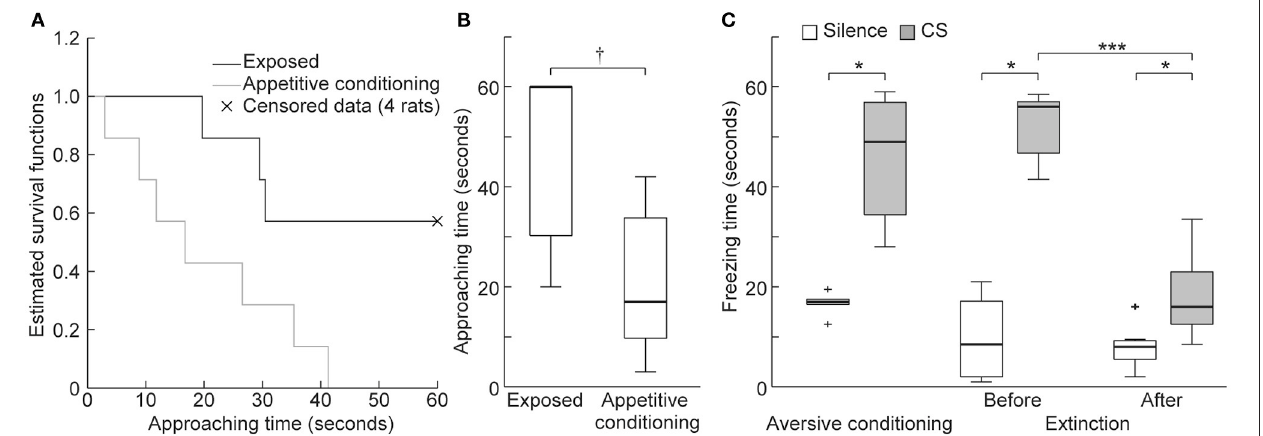
FIGURE 6 | Behavioral experiments. (A) Kaplan-Meier survival functions to quantify approaching behavior to the food dispenser during the conditioned stimulus (CS) presentation. The four animals in the exposed group that did not exhibit poking during the 60s presentation of the CS are indicated as censored data ( × marks). The null hypothesis that there is no difference between the two groups in the probability of poking at any time point was rejected (log-rank test, p = 0.038). (B) Approaching time of the exposed and appetitive conditioning groups. Statistical significance: † p < 0.05 (Wilcoxon rank sum test, n = 7 per group). (C) Freezing times in the aversive conditioning and extinction groups. Statistical significance: * p < 0.05; *** p < 0.001. (Wilcoxon signed-rank test, n = 7 per